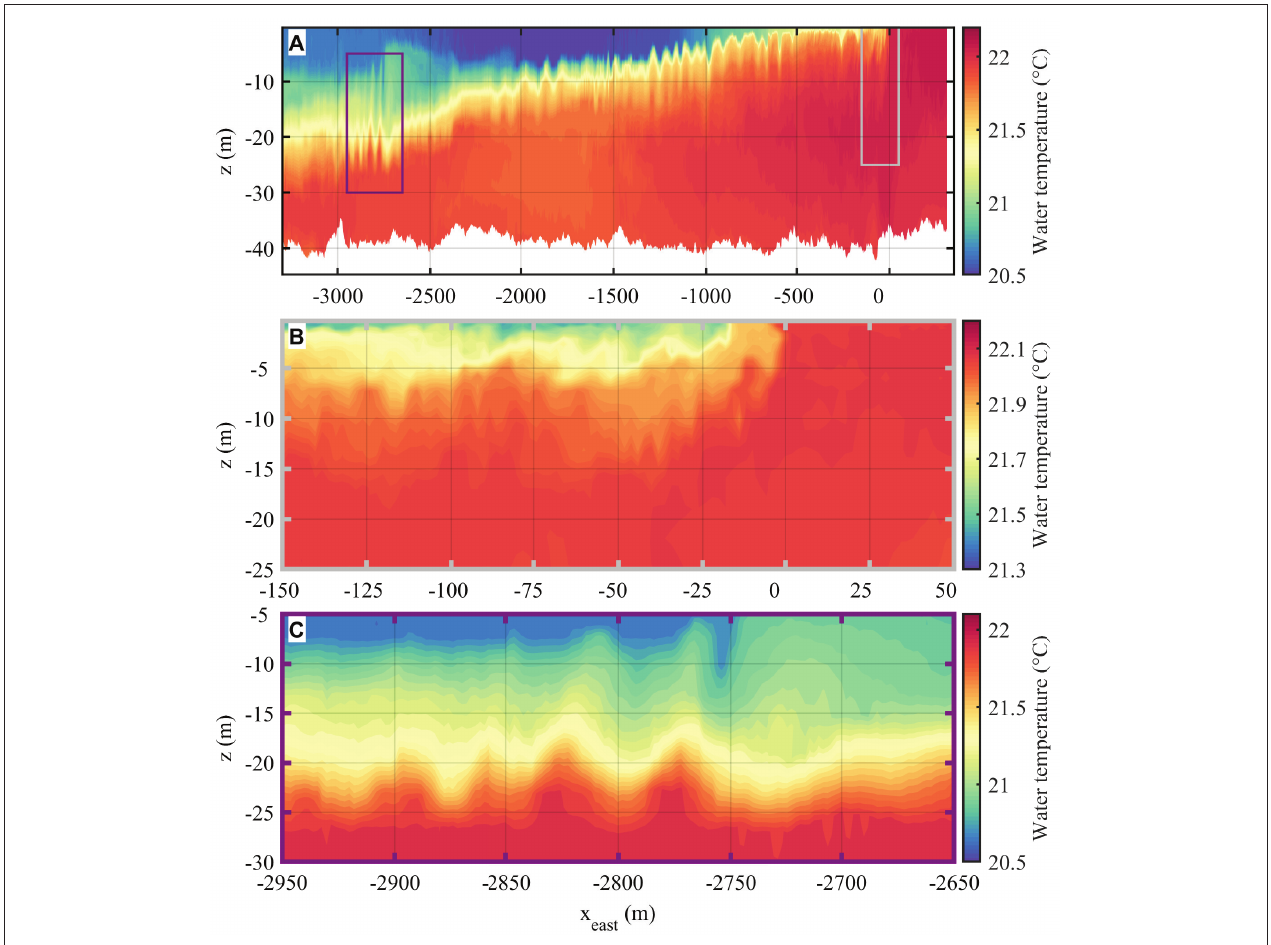
FIGURE 14 | Variations of the water temperature along a 3.6 km long (140 min) transect while crossing a front during the LASER2016 experiment. (A) The entire transect. (B) Zoomed in view of 200 m across the frontal interface. (C) Zoomed in view of the transect while sampling across internal-types waves. In the first 50 m after crossing the front (see B ), the top nodes of the T-Chain experienced the sharp change of temperature before the bottom nodes, highlighting the slope of the front. As the Wave Glider moved away from the front (see A ), fluctuations of the temperature in the top layers increased in amplitude and in width. In the first 500 m, small fluctuations ( 0.4 ◦ C) occurred within the first 2 m of the water column while further away (750–1,500 m), the amplitude of the water temperature fluctuations ∼ reached almost 1 ◦ C and affected deeper layers. Around 2,800 m away from the front, internal-type waves are observed (see C